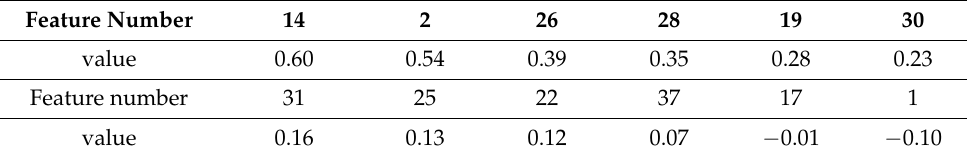
Figure 8. Correlation matrix of bearing B1. Table 4. RMI Values of the selected features.